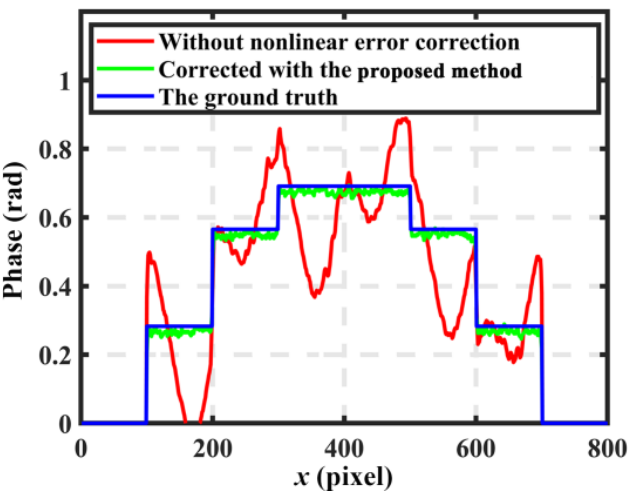
Figure 5. Results of the simulated step heights. ( a ) absolute phase recovered without corrections; ( b ) absolute phase corrected with the proposed method; and ( c ) the ground truth of the simulated object. Unit: rad.